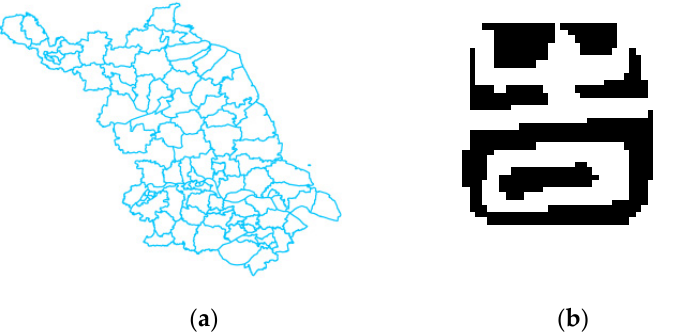
Figure 8 . The verification process of questionable data forensics. (a) County-level administrative Figure 8. The verification process of questionable data forensics. ( a ) County-level administrative boundaries of Jiangsu province. (b) Copyright image. boundaries of Jiangsu province. ( b ) Copyright